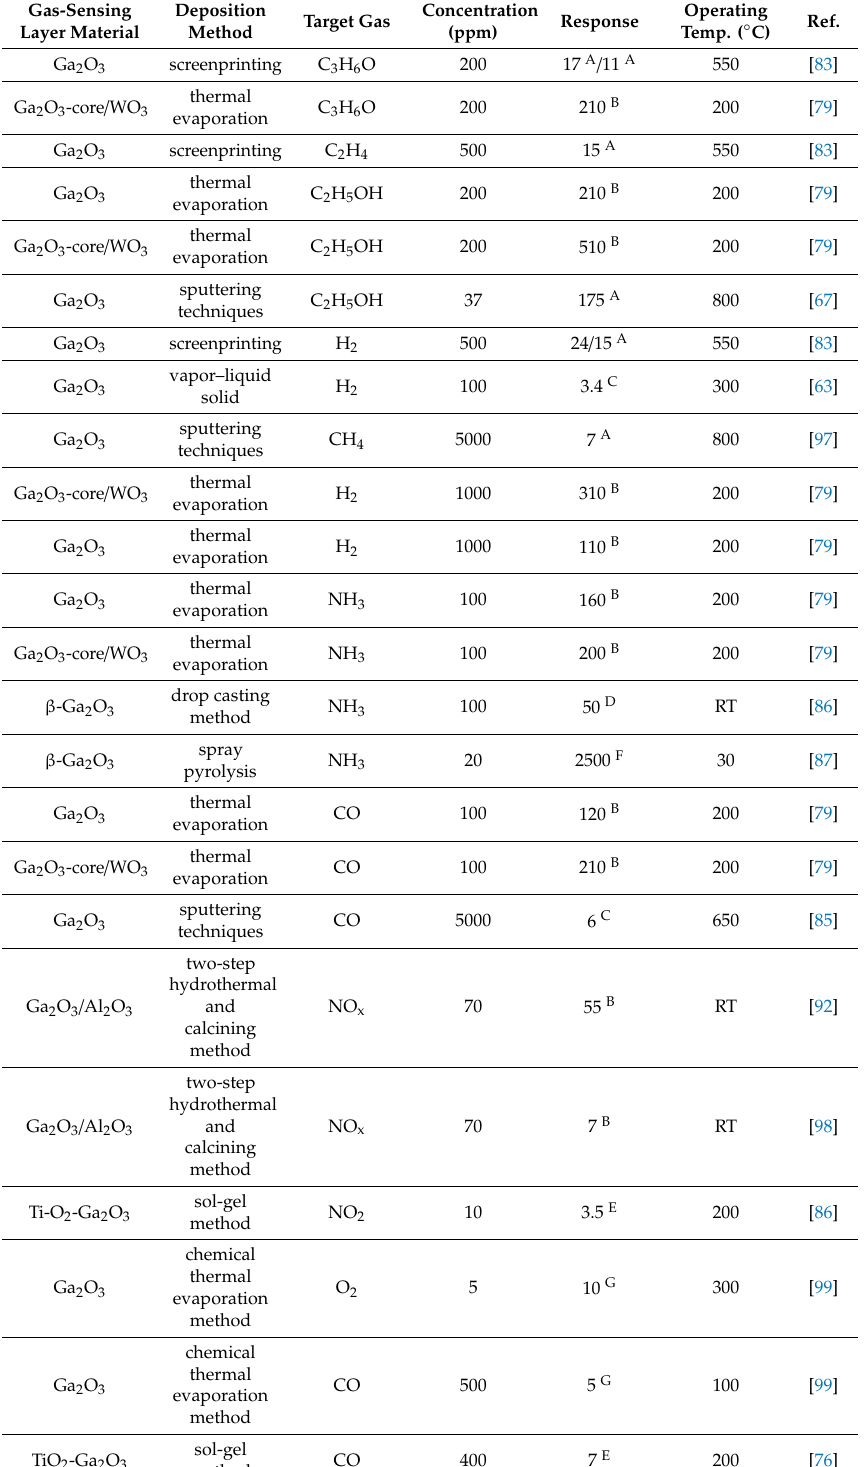
Table 1. The summary of the recently presented research results on gas-sensing